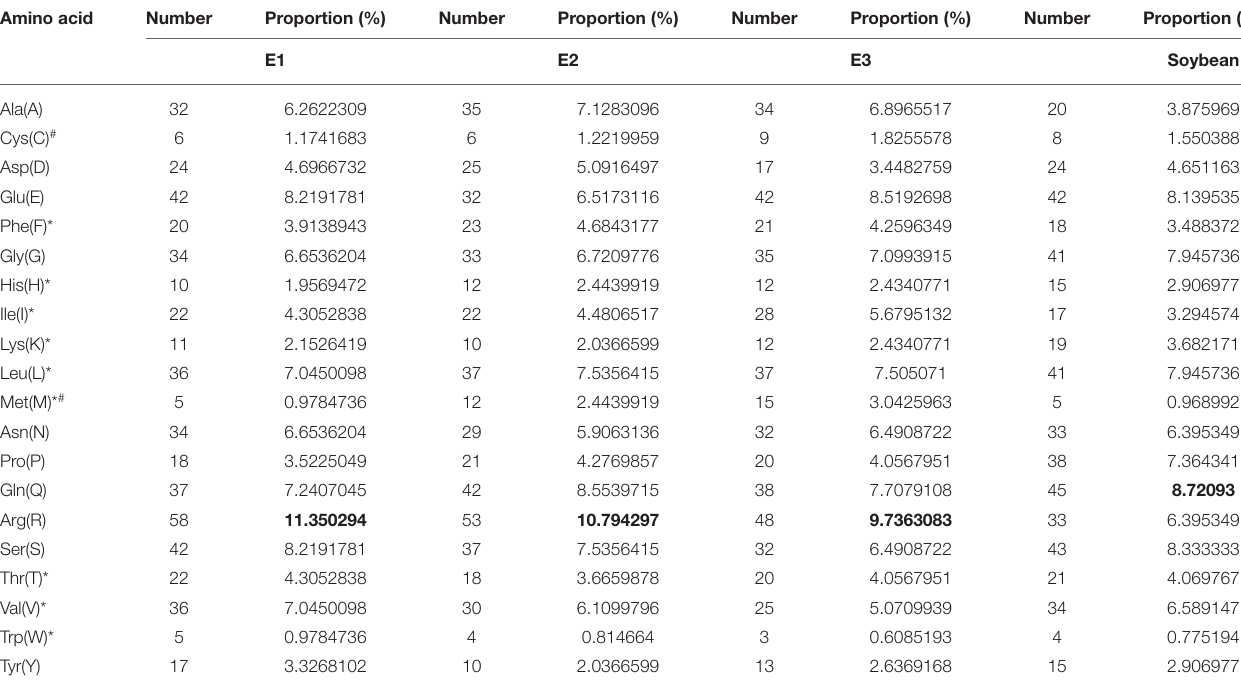
TABLE 5 | Amino acid composition of 11S